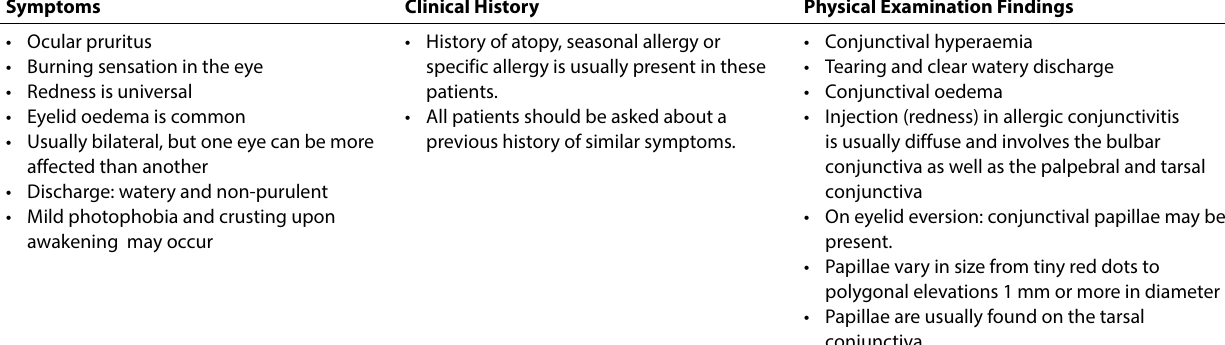
Table 2: Clinical presentation of allergic conjunctitivis 1,17-20